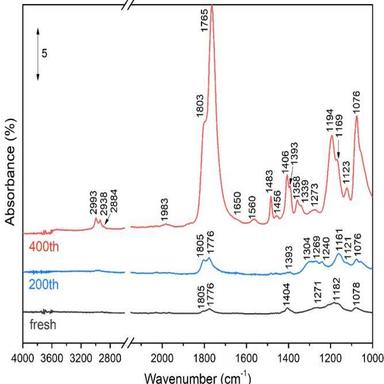
FTIR spectra of the fresh and cycled cells (200th and 400th).